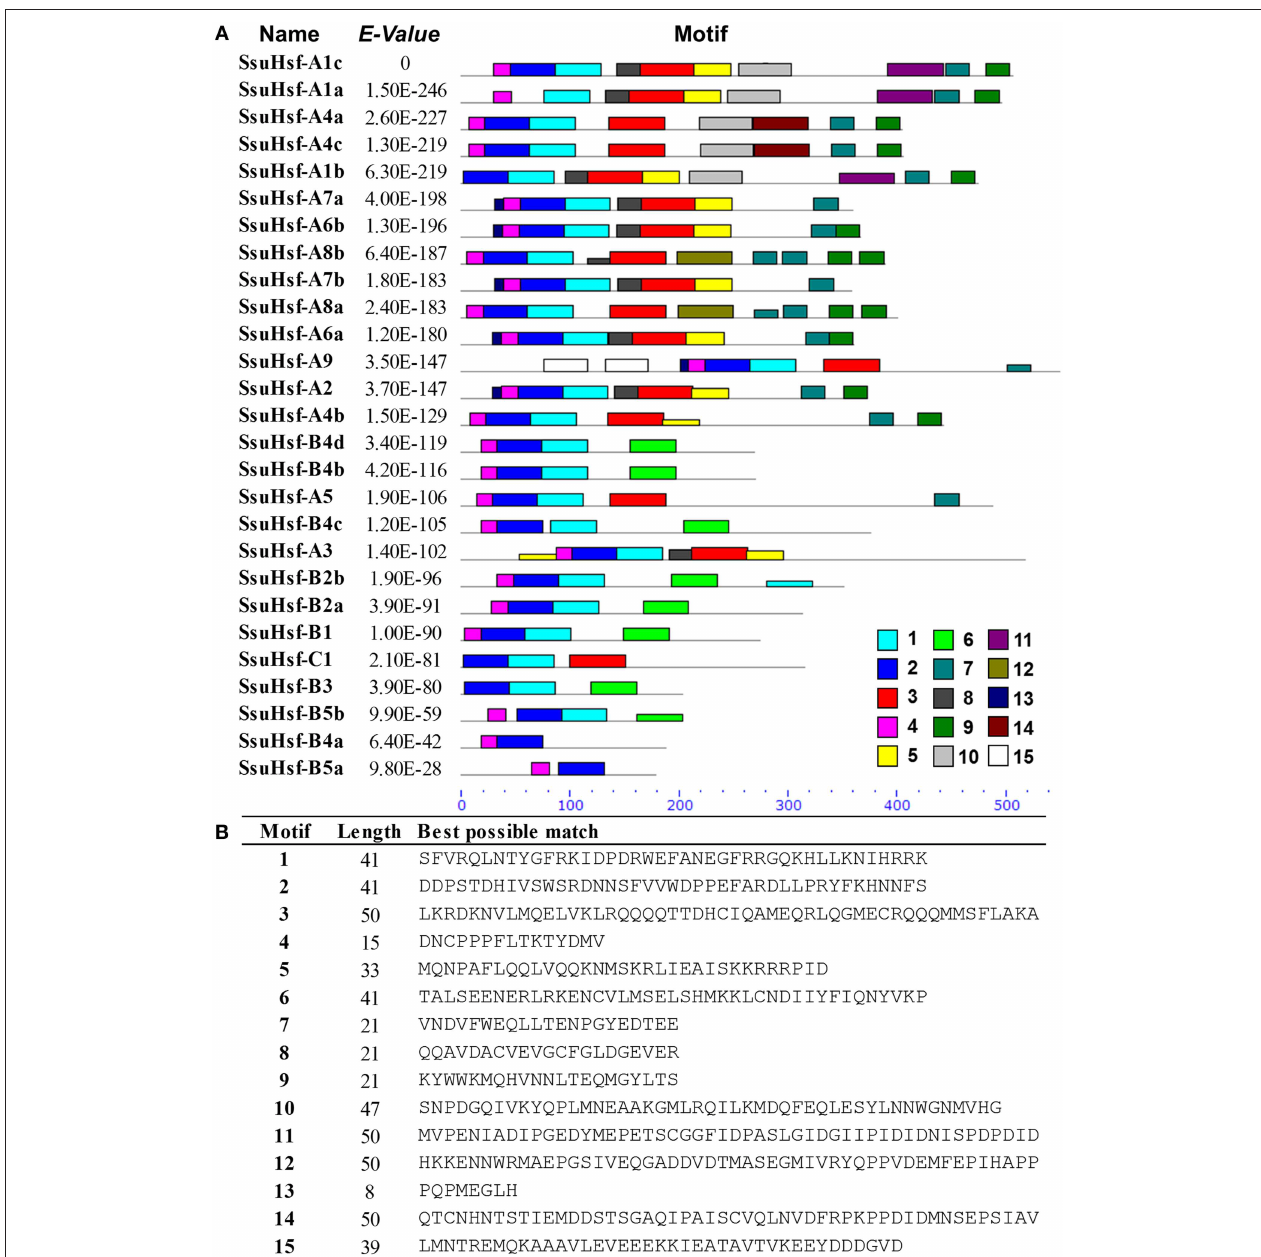
FIGURE 5 | Distribution of conserved motifs in the SsuHsf proteins. (A) The motifs were identified by MEME. Different motifs are indicated by different colored numbers 1–15. (B) The detail motif